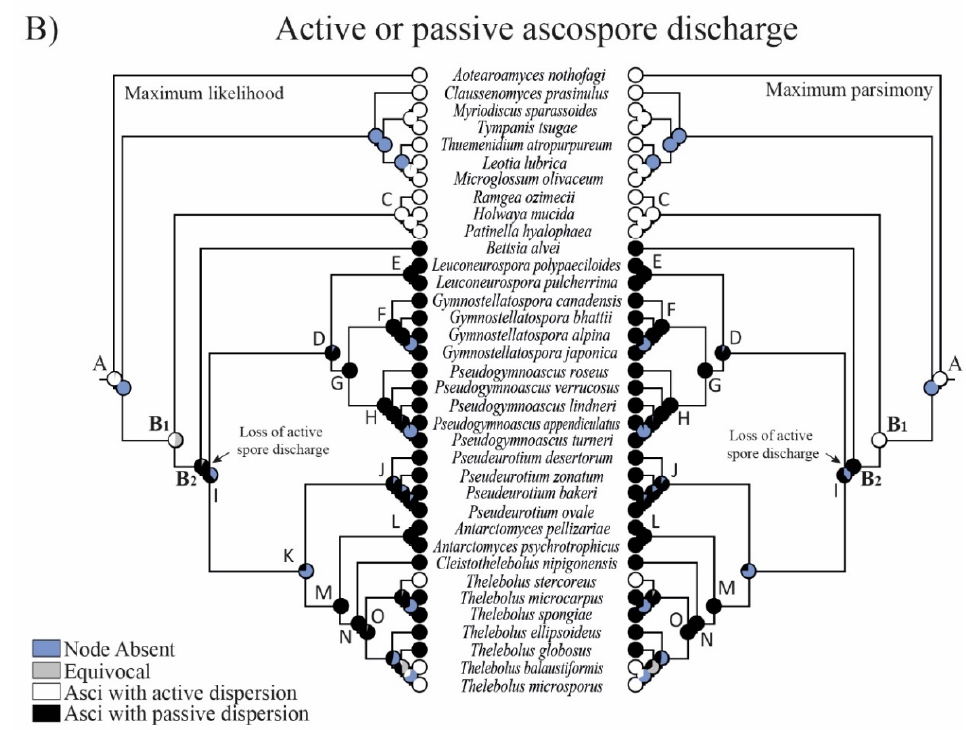
Figure 2. Evolution of ( A ) ascoma type and ( B ) active or passive ascospore discharge using parsimony and likelihood methods across 8000 BMCMC trees obtained from MrBayes. Pie charts at each node illustrate the likelihood (left) and parsimony (right) reconstruction and the proportion of the average received by each character state as the ancestral character of a given clade. Node absent indicates the proportion of nodes with posterior probabilities < 0.95 across trees. Equivocal indicates the same probability for the different features (not resolved).